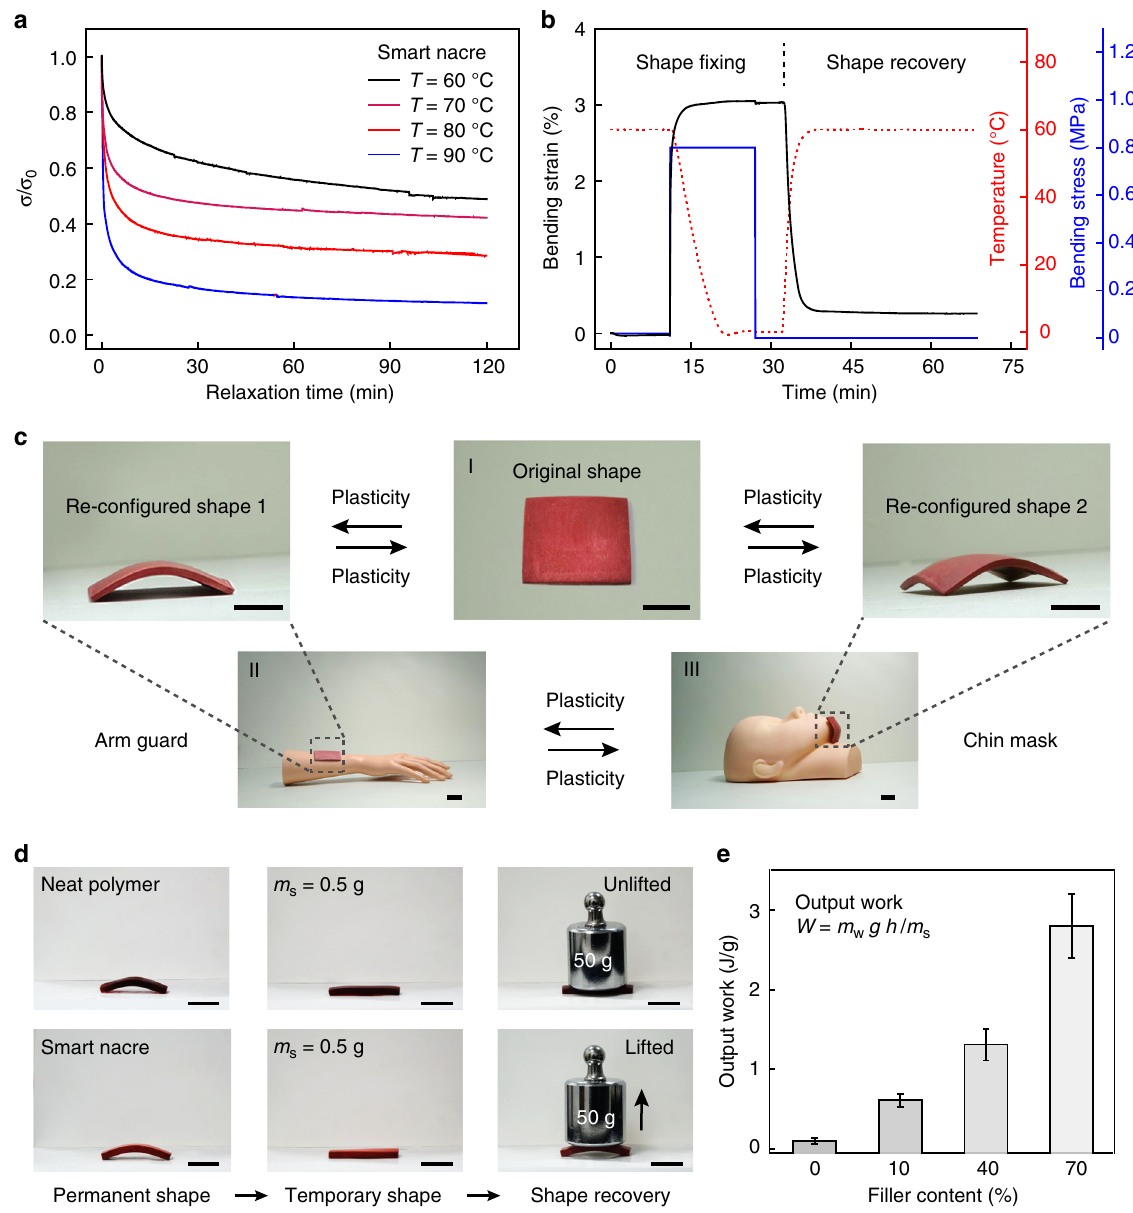
Fig. 4 Shape programmability of the smart nacre. a Stress relaxation of the smart nacre under iso-strain conditions (3%). b Elasticity-based shape memory cycle of the smart nacre. c Shape re-con fi guration via plasticity. d Shape recovery under a 50 g load for neat polymer and the smart nacre ( V f = 70%). e Summary of the output work ( W = m w gh / m s ) for neat polymer and smart nacres with various fi ller contents, in which m w , g , h , and m s represent the load, gravitational acceleration, lifted height, and sample weight, respectively. Error bars represent standard deviations calculated from fi ve specimens. Scale bar in c is 2 cm and in d is 1